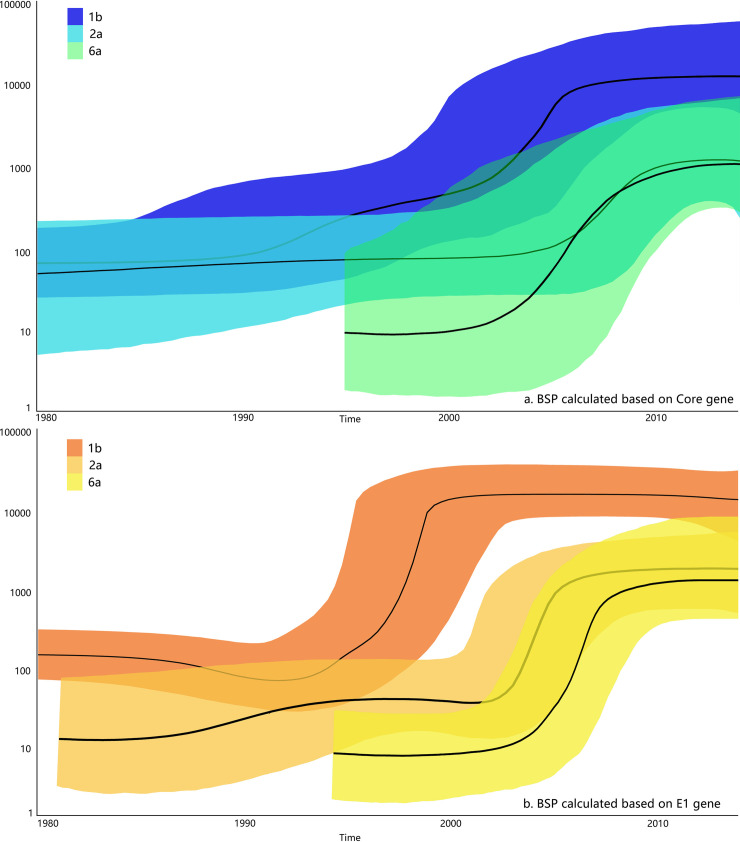
Population genetic characteristics of HCV with different genotypes among blood donors in China.The solid black part is the median of the estimated changes in genetic diversity. Other colored parts is the 95% confidence interval. The horizontal axis is the year. The vertical axis is Neτ (the effective population size of the experimental sample). a: The BSP for HCV 1b(blue), 2a(light blue) and 6a(green) based Core gene. b: The BSP for HCV 1b(orange), 2a(light orange) and 6a(yellow) based E1 gene.